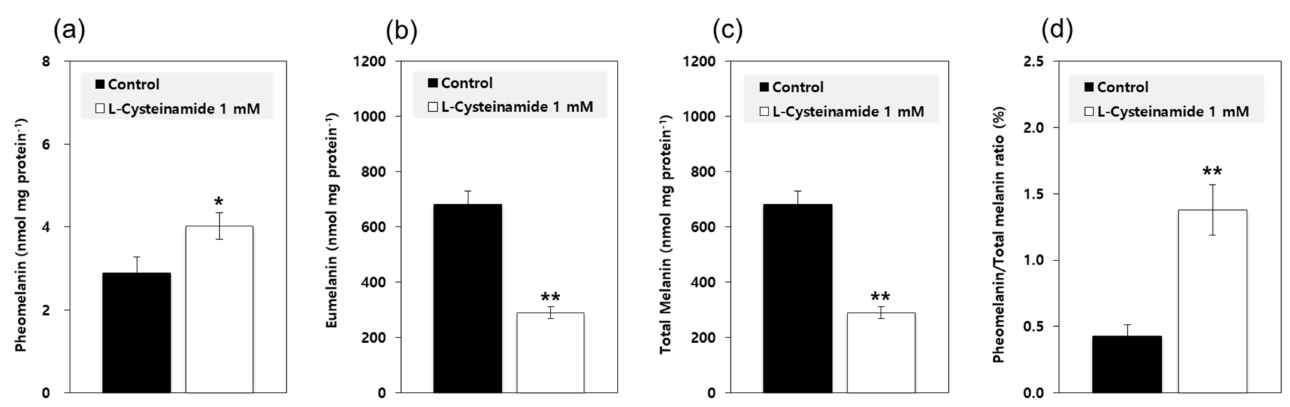
Figure 10. Effects of L-cysteinamide on the pheomelanin and eumelanin contents of MNT-1 cells. Cells were treated with vehicle (control) or 1 mM L-cysteinamide for 72 h. The contents of pheomelanin ( a ) and eumelanin ( b ) were separately estimated and used to calculate the total melanin contents ( c ) and the pheomelanin to total melanin ratios ( d ). Data are presented as means ± SD ( n = 3). * p < 0.05 vs. control; ** p < 0.01 vs.